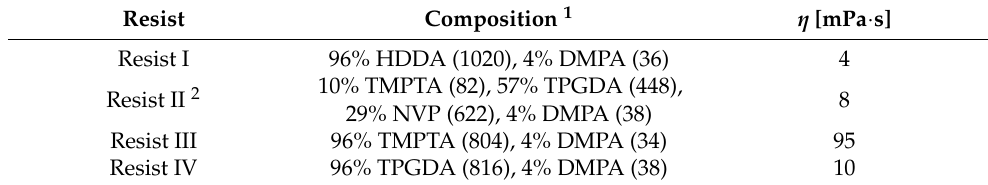
Table 1. Compositions and measured viscosities ( η ) of the four resist materials examined in this